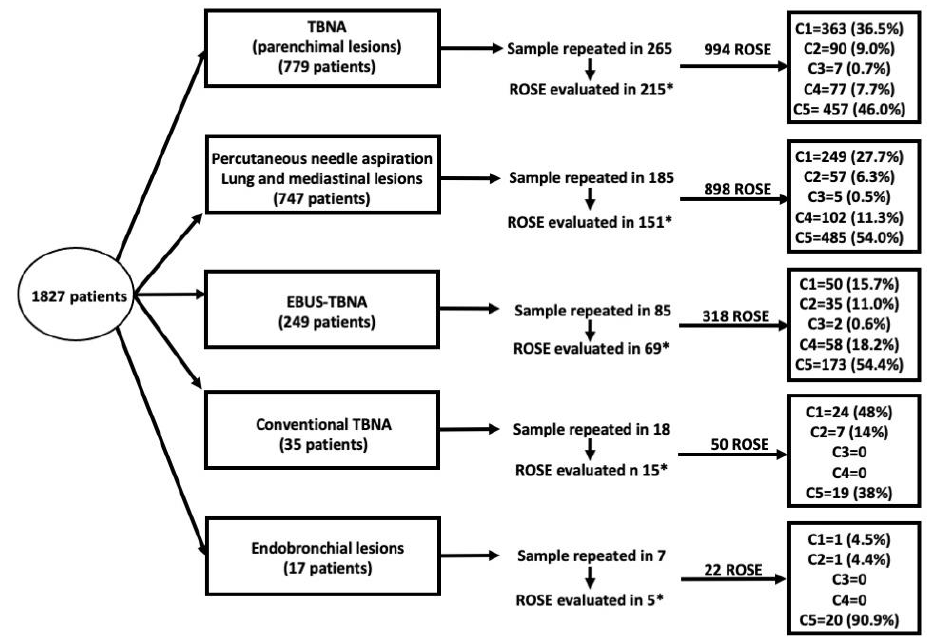
Figure 1. Diagnostic flow with the number of ROSE and C1–C5 categories for each procedure. * ROSE was not performed in 105 patients at the second or third sampling.